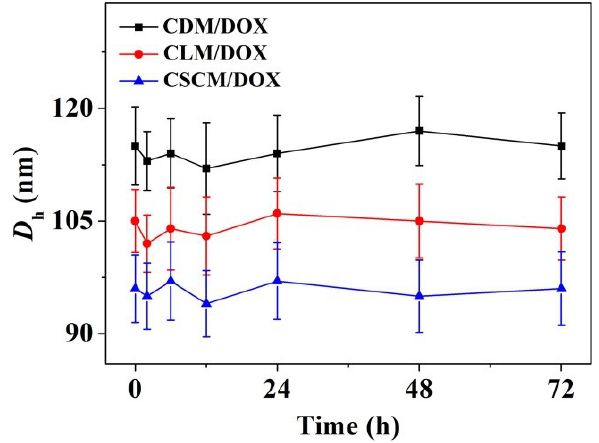
Figure 2. D h changes of CDM/DOX, CLM/DOX, and CSCM/DOX versus time in PBS at pH 7.4, 25 °C. Each set of data was presented as mean ± standard deviation (SD) ( n = 3).